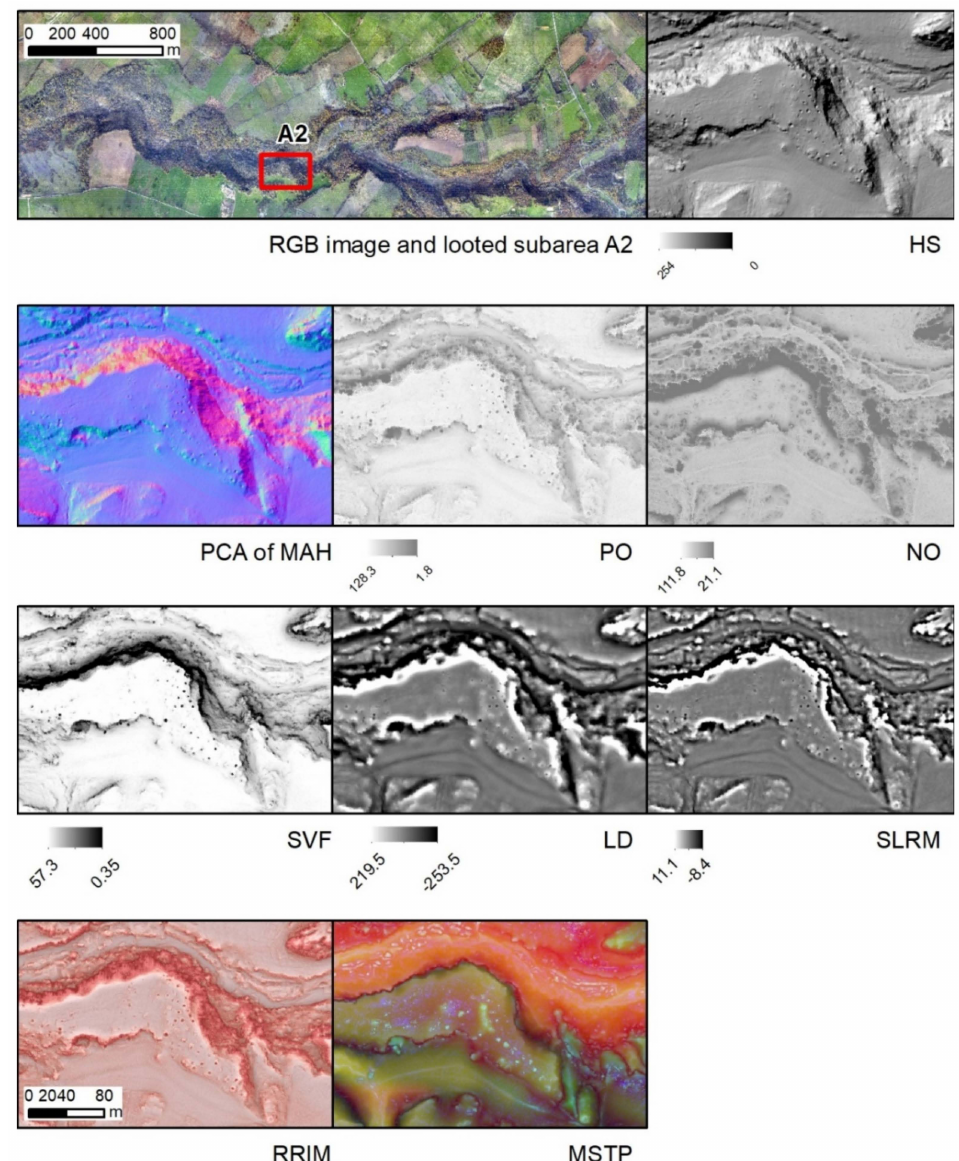
Figure 5. The subarea A2 found with VTs affected by looting. In the left-high corner, the localization of the A2 subarea is overlaid to the RGB image. In the other frames the different VT results are